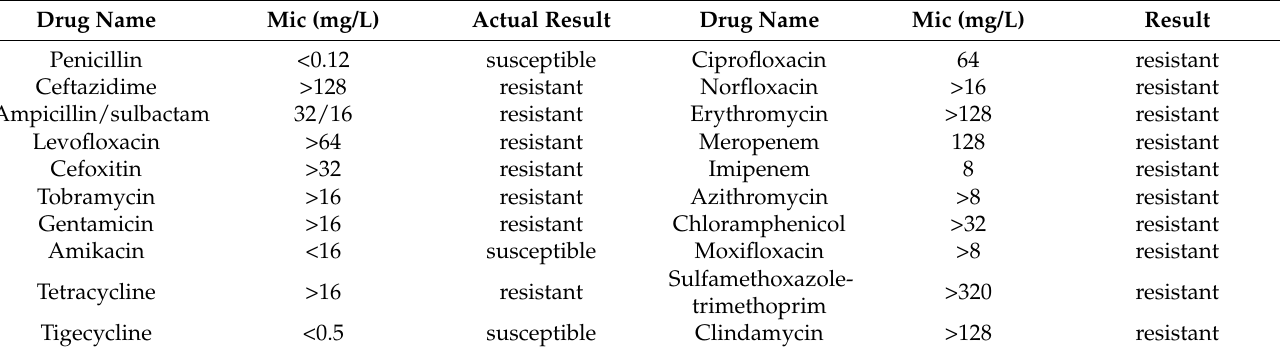
Table 5. Results of the drug sensitivity test (broth microdilution method).